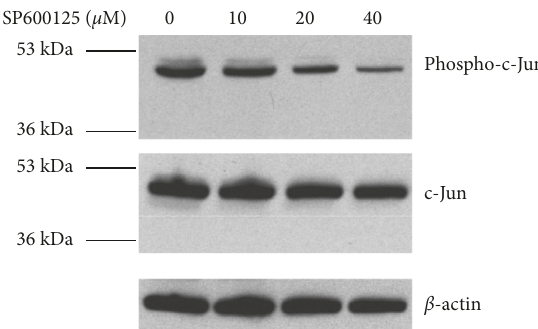
Figure 5: JNK inhibitor (SP600125) can reduce the activation of c-Jun in a dose-dependent